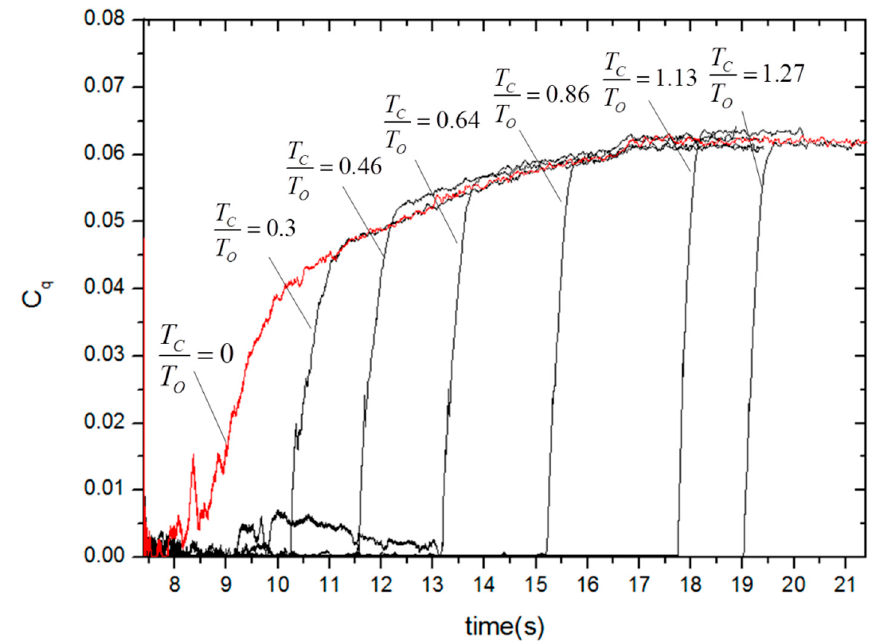
Figure 8. Dimensionless flow for different startup periods.